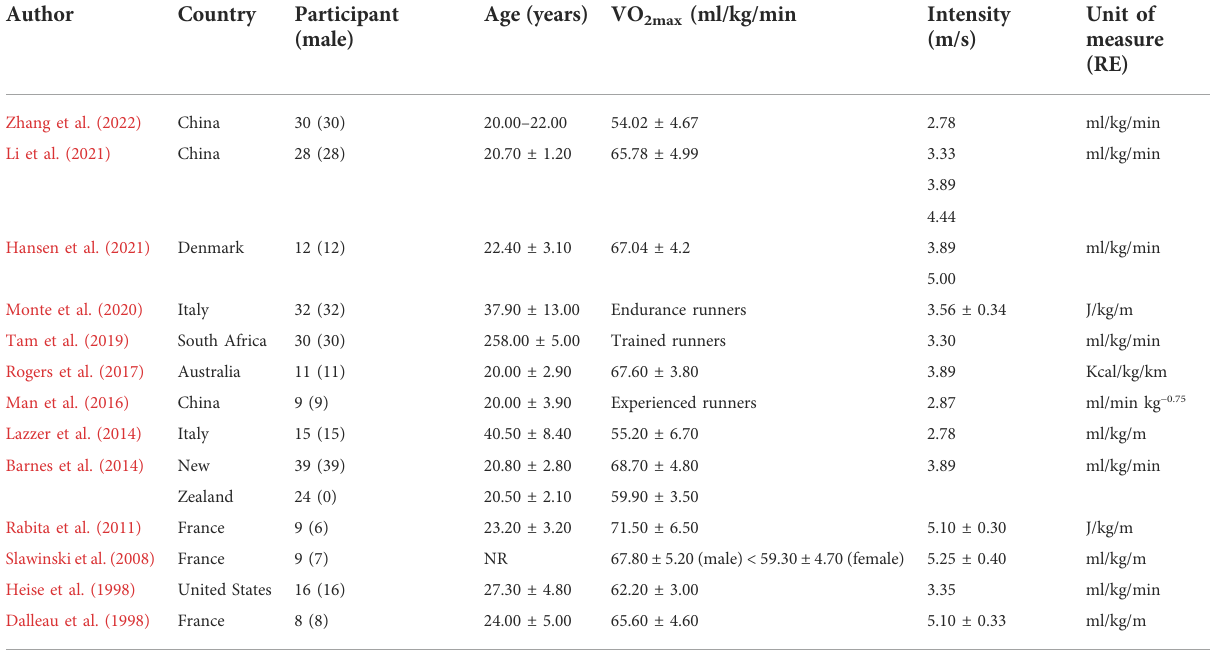
TABLE 1 Characteristics of the included